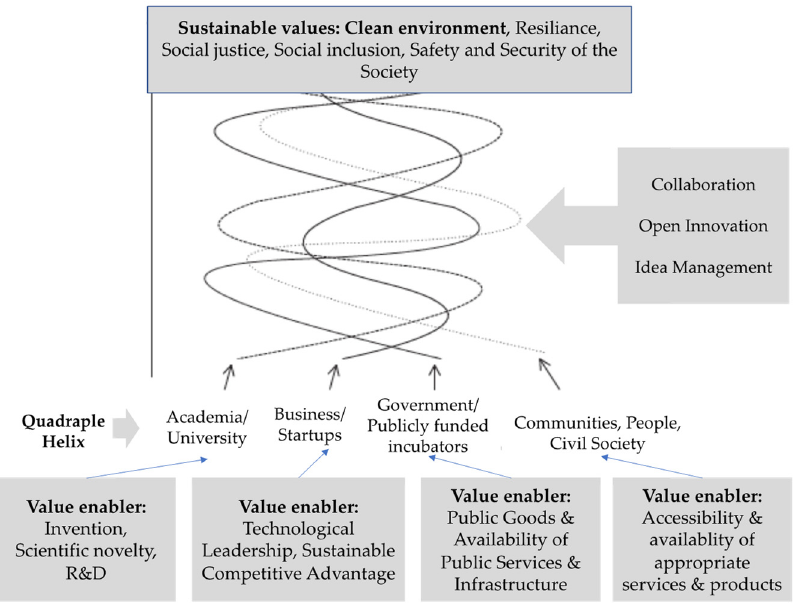
Figure 6. Conceptual model of sustainable value creation (source: the authors).